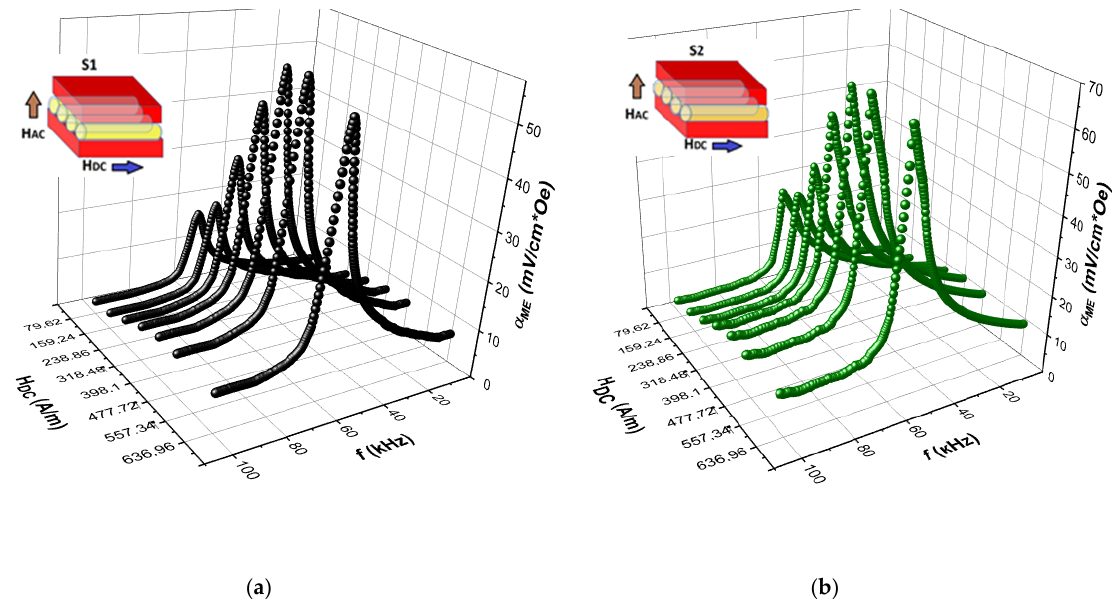
Figure 6. Frequency dependencies of the ME voltage coe ffi cient for di ff erent DC bias field H DC for sandwiches with glass coated microwires (as-prepared—S1 (a) and after annealing—S2 (b)).